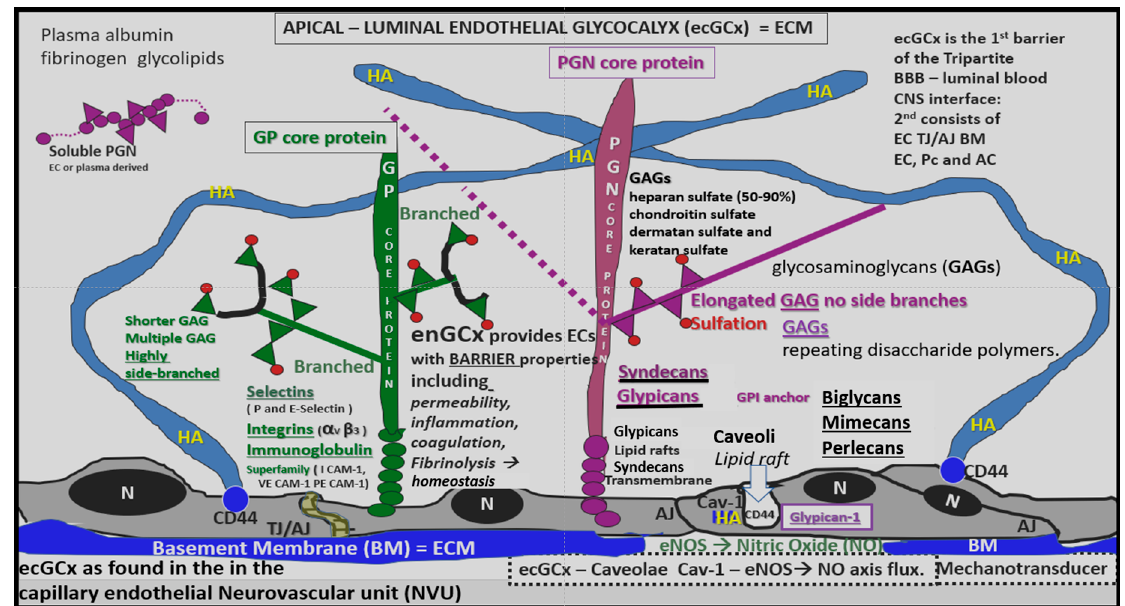
Figure 5. The endothelial glycocalyx as the first of component of the “tripartite BBB”. Normal components of the endothelial glycocalyx (ecGCx): a unique extracellular matrix. The ecGCx is composed of two classes of proteins that are mostly anchored [proteoglycan(s) (PGN) (purple), glycoprotein(s) (GP) (green)] and of hyaluronic acid (HA) hyaluronan (an exceedingly long polymer of disaccharides non-sulfated glycosaminoglycan). (HA) (blue) may be either unattached (free floating), attached to CD44 brain endothelial cell(s) (BEC) plasma membrane, or form HA-HA complexes. Non-sulfated HAs not anchored to the BECs may reversibly interact at the lumen with plasma-derived albumin, fibrinogen and soluble PGNs. The PGNs and glycoproteins side chains consisting of glycosaminoglycans (GAGs) covalently bound to core proteins are highly sulfated (red dots). The two primary PGNs are the syndecans and glypicans. The glycoproteins consist primarily of selectins (P and E), integrins (alpha v and beta 3) and immunoglobulin superfamily of ICAM-1, VE-CAM and PE CAM-1. Caveolae are invaginations of lipid rafts of the endothelial plasma membrane and contain CD44 important which anchors hyaluronan to the BEC plasma membrane and glycosylphosphatidylinositol (GPI) which anchors glypican-1. The GPI/glypican-1 interaction is thought to activate endothelial nitric oxide synthase (eNOS) to produce bioavailable nitric oxide (NO) via the calcium calmodulin dependent Caveolin-1 (Cav-1)